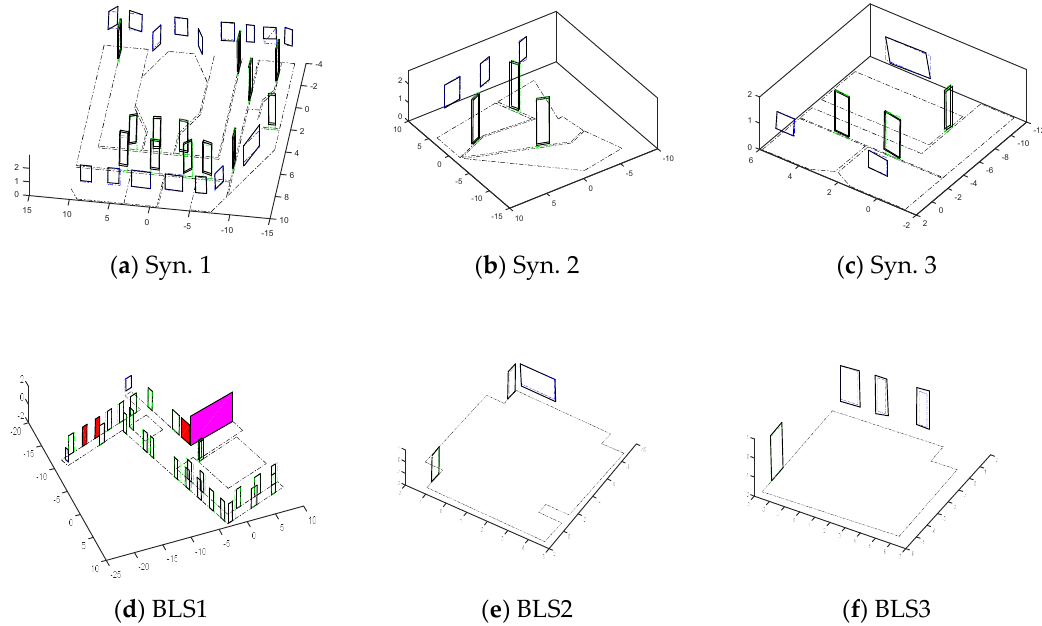
Figure 9. Evaluation of wall-surface objects from the constructed model from our approach (blue color